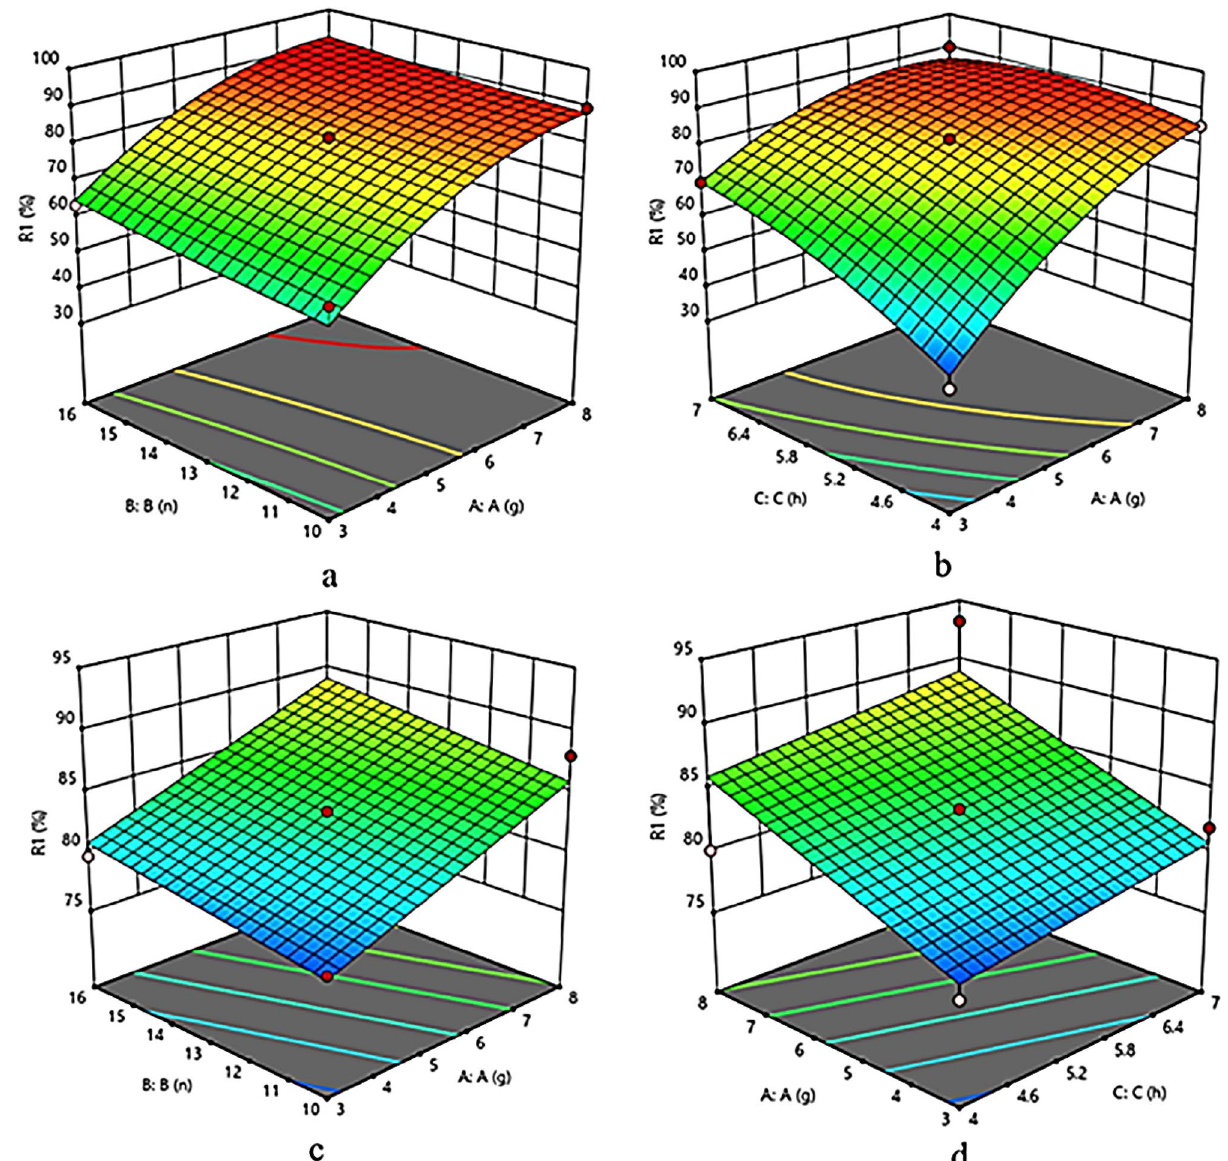
Figure 13. 3D response surface plots of catalyst concentration and M:O for rapeseed oil ( a ); catalyst concentration and time for rapeseed oil ( b ); catalyst concentration and M:O for waste corn oil ( c ); catalyst concentration and time for waste corn oil ( d